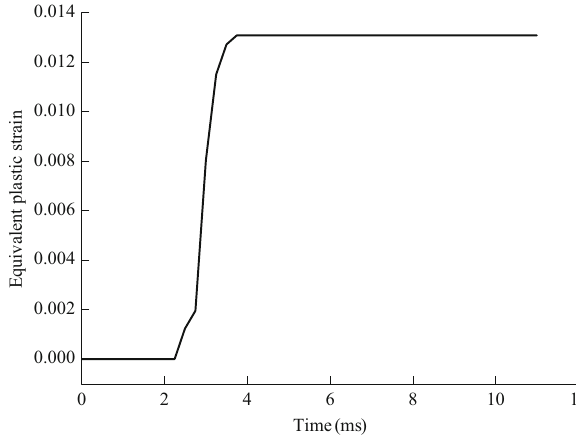
Fig. 2 Time history curve of typical vertical wheel–rail impact force under the train speed of 200 km/h, flat length of 60 mm and axle load